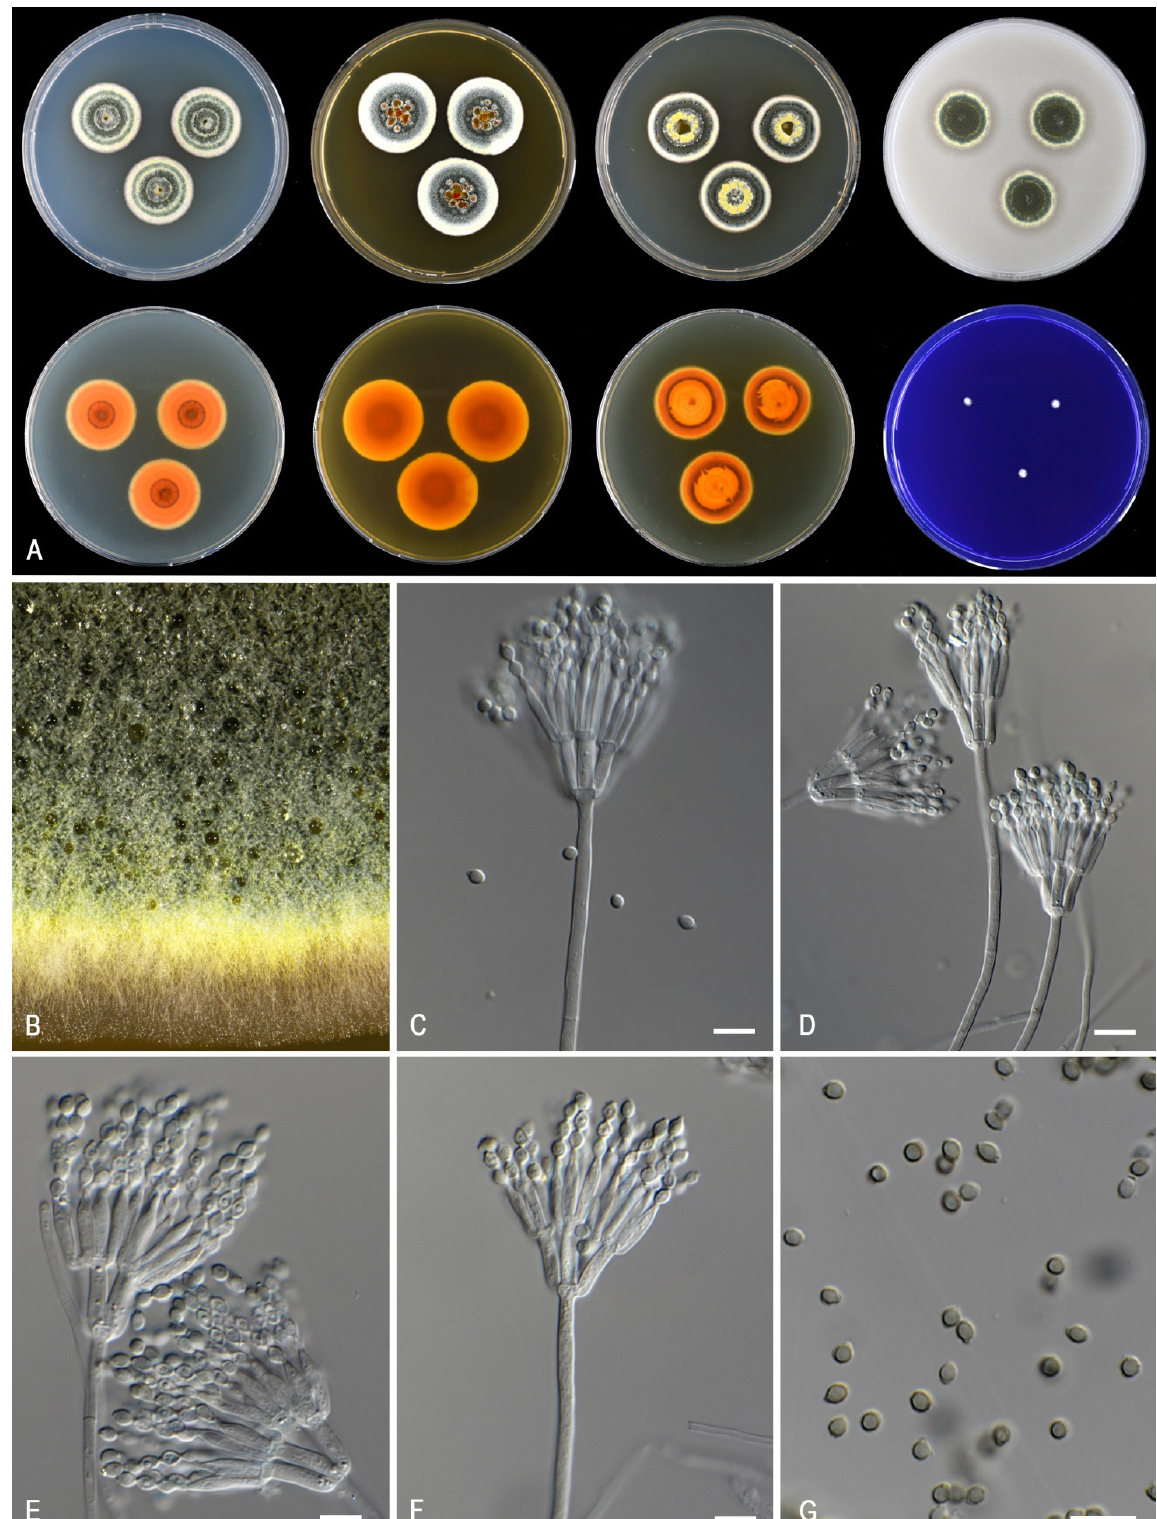
Figure 6. Morphological characters of Talaromyces calidominioluteus (DTO 390-E9). ( A ). Colonies, from left to right, after 7 d at 25 °C (top row) CYA, MEA, YES, OA; (bottom row) CYA reverse, MEA reverse, YES reverse, CREA. ( B ). Detail of colony on MEA. ( C – F ). Conidiophores and conidia. ( G ). Conidia. Scale bars = 10 μ m.